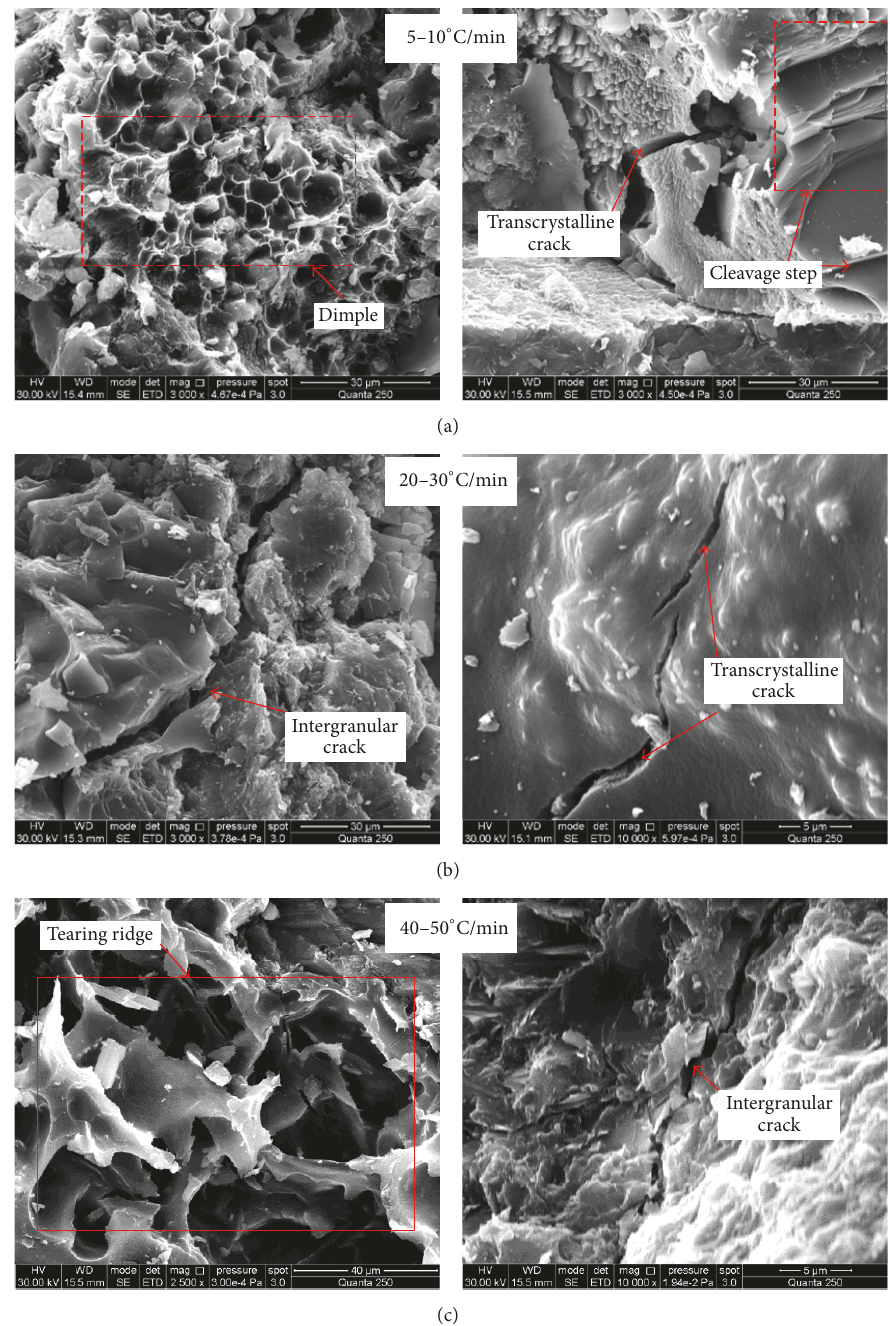
Figure 12: Microproperties of fracture morphology in the sandstone after loading